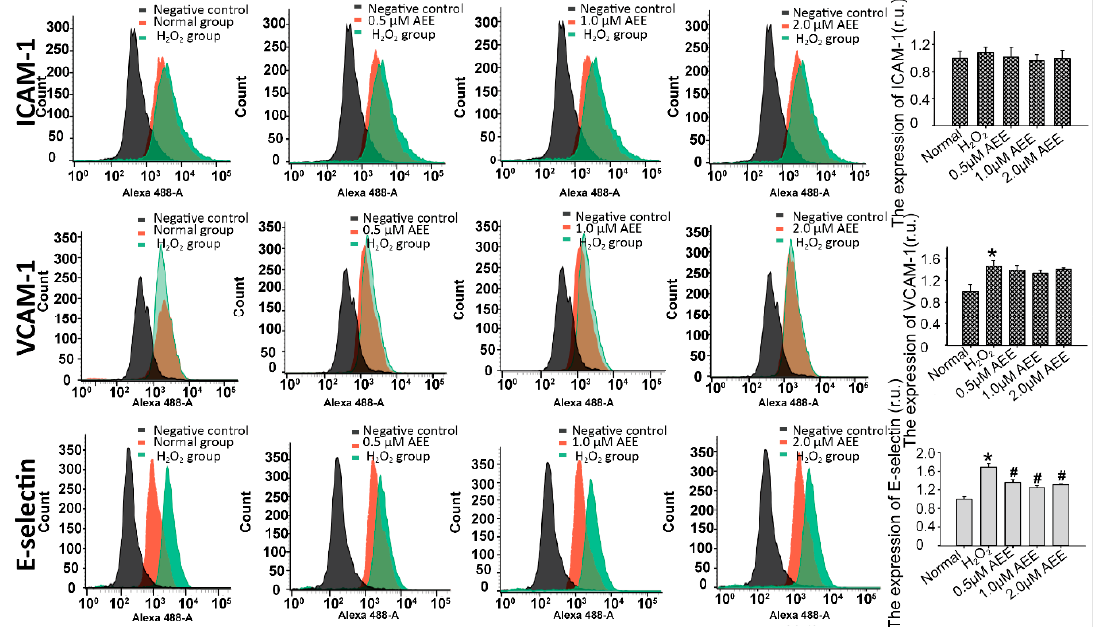
Figure 2. AEE decreased H 2 O 2 -induced E-selection expression in HUVECs. Values are presented as the means ± SD where applicable ( n = 8). * p < 0.05 compared with the normal group; # p < 0.05 compared with the H 2 O 2 group. All data were normalized to the corresponding control and in relative units